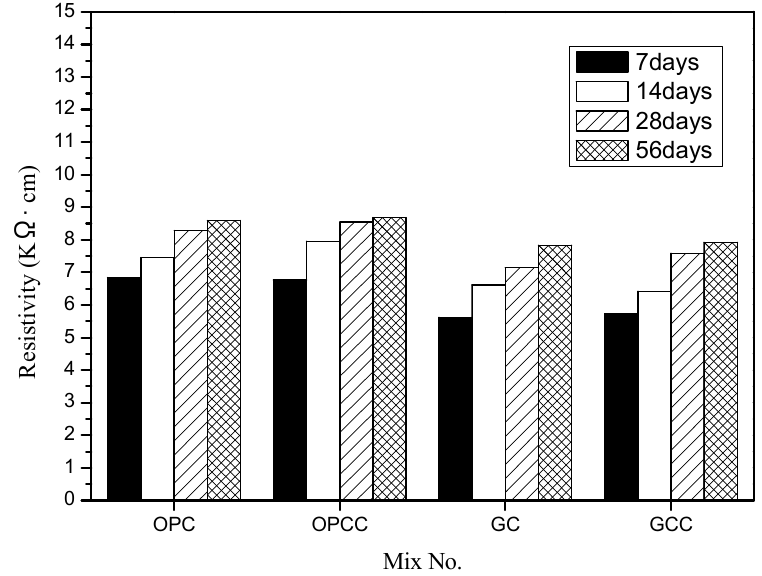
Figure 9. Comparison of concrete resistivity.